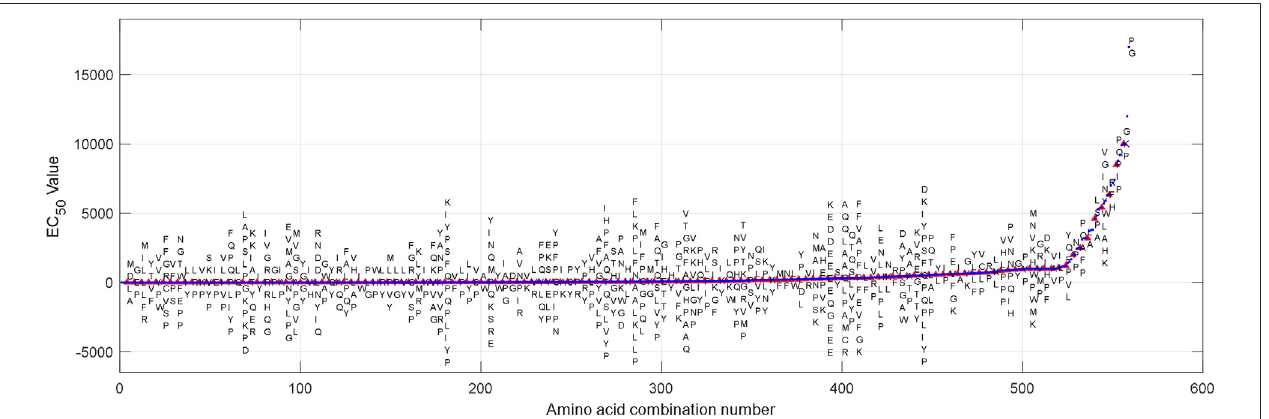
FIGURE 1 | Constructed time series of natural logarithm of AHTPA-EC 50 and its corresponding amino acid combination.